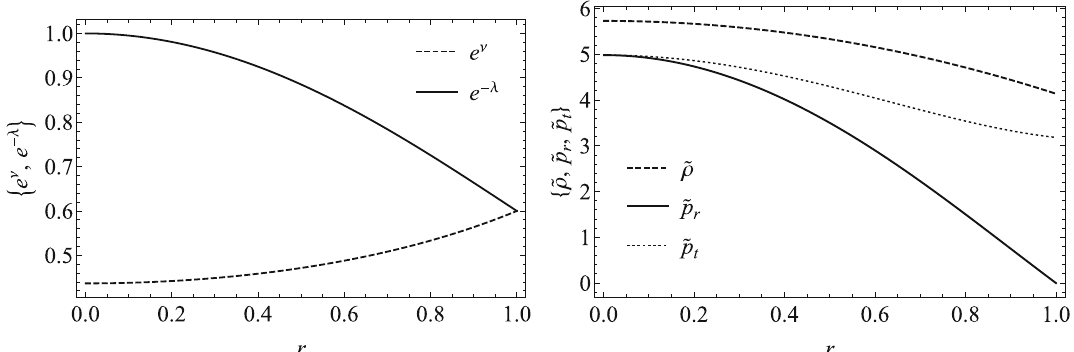
Fig. 1 Metric functions { e ν , e − λ } (left panel) and matter sector { 10 2 × ˜ ρ , 10 3 × ˜ p r , 10 3 × ˜ p t } (right panel) as a function of the radial coordinate r , for M / R = 0 . 2 and β = − 0 . 52 for the like-Tolman VII model Fig. 2 Left panel: exchange of energy 10 2 × Δ E for different values of C . Right panel: density plot of the exchange of energy for C = − 1 for the like-Tolman VII model. In both cases we have taken M / R = 0 . 2 and β = − 0 .